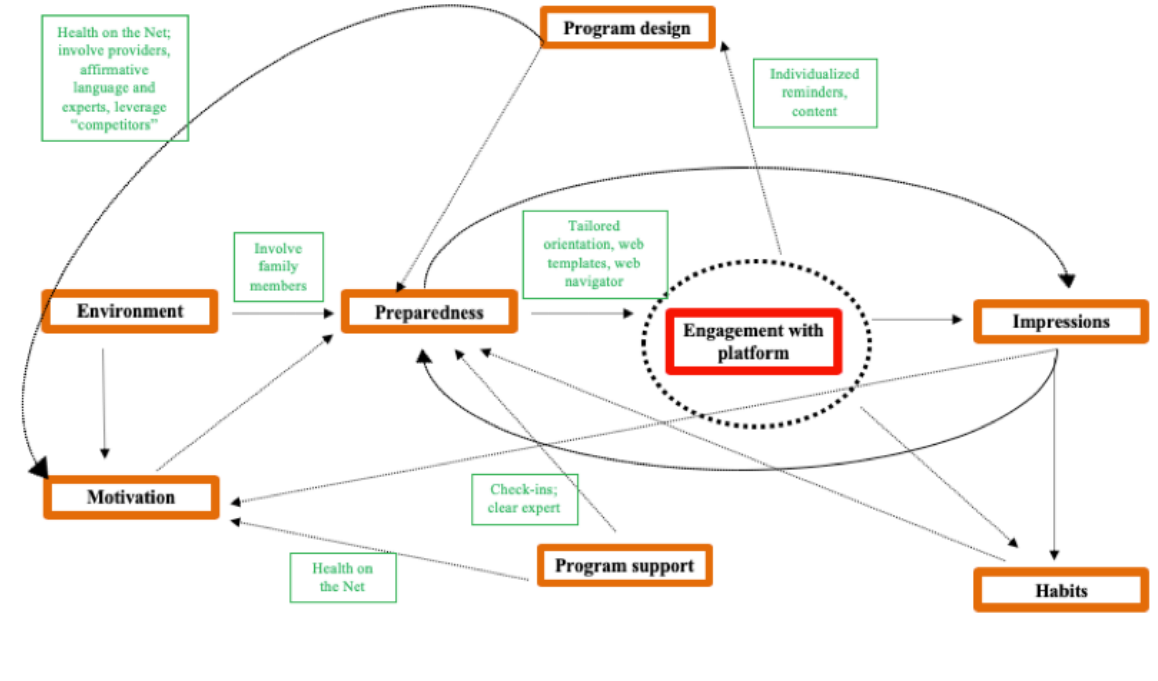
Figure 4. Grounded theory-based approaches to increasing prostate cancer survivors’ engagement with web-based Community of Wellness lifestyle intervention: relationships among barriers and motivators related to engagement with web-based behavioral support, with potential solutions (green, ie, Health on the Net).